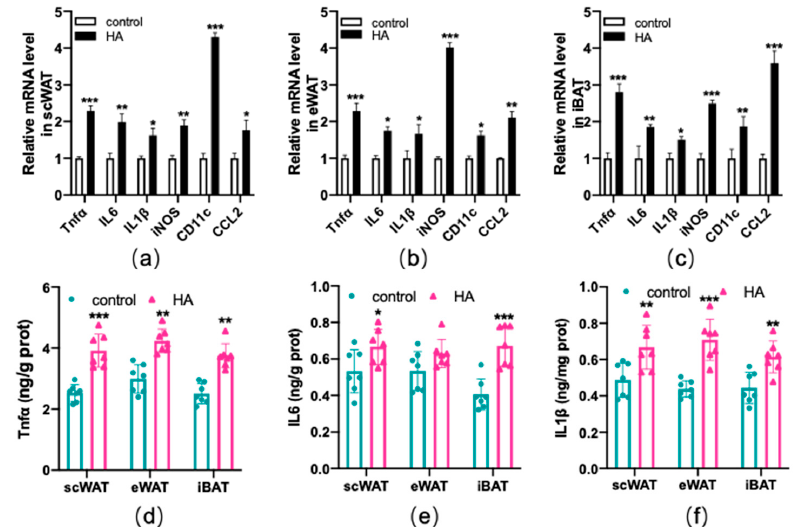
Figure 5. Production of inflammatory-related factors in both WAT and BAT after exposure to HA. Graphs ( a – c ) display RT − qPCR of inflammatory-related genes after HA exposure. Graphs ( d – f ) display Tnf α , IL6, and IL1 β assay after 4-week-long exposure to HA (ELISA). Data are expressed as the mean ± SEM; n = 7. * p < 0.05, ** p < 0.01, and *** p < 0.001, compared with the control group.